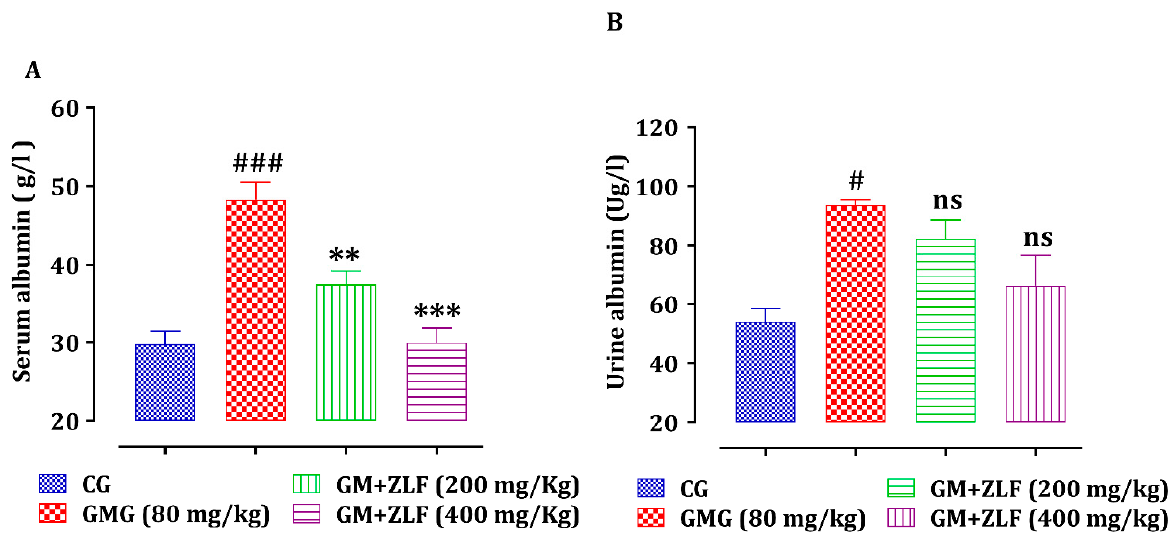
Figure 6. Effect of ZLF’s on serum and urine albumin in GM-exposed rats. The data are presented as mean ± SEM, ( n = 6). # p ≤ 0.05 ### p ≤ 0.001 versus NCG. ** p < 0.01, *** p < 0.001 versus GMG. ns: not significant versus GMG. GM: gentamicin; CG: Control Group; GMG: GM treated Group.